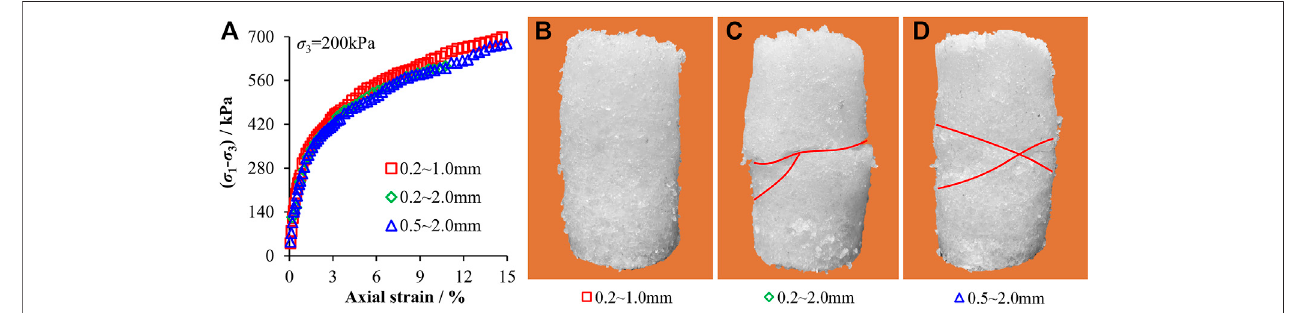
FIGURE 15 | Stress – strain responses (A) and failure modes of the specimens with different particle gradations (separately 0.2 – 1.0 mm (B) , 0.2 – 2.0 mm (C) and 0.5 – 2.0 mm (D) ) of fused quartz.